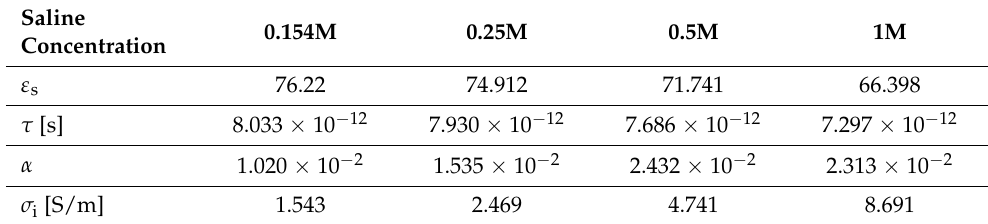
Table 1. Cole–Cole parameters of the analyzed saline